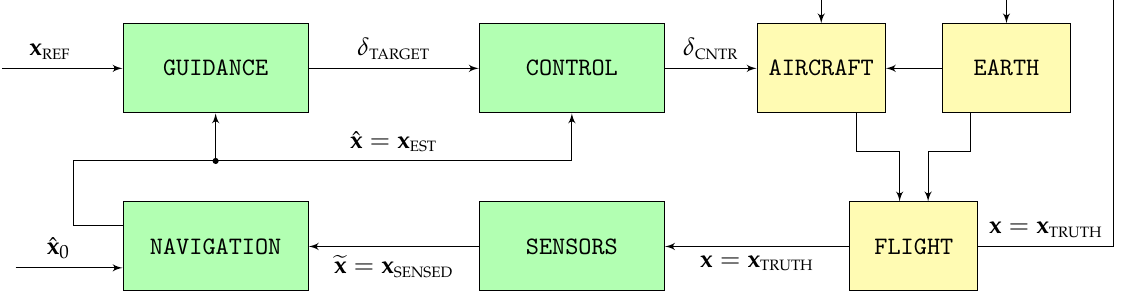
Figure 4. Components of the high-fidelity simulation.